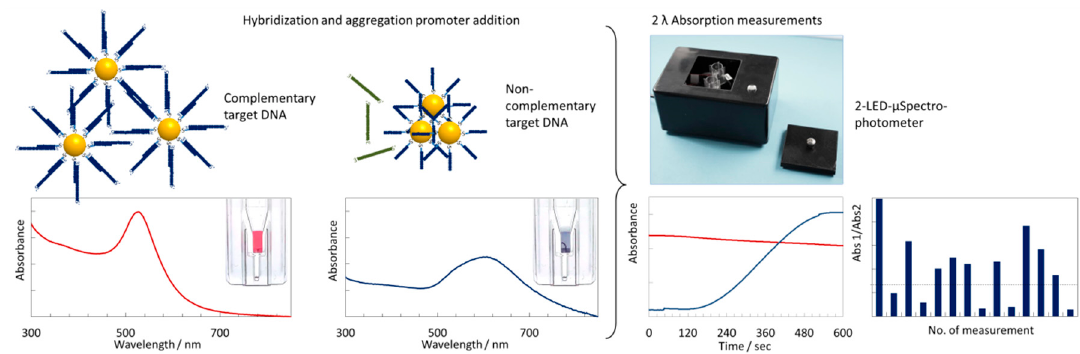
Figure 2. Schematic representation of the DNA sensing strategy. In the presence of DNA and an aggregation promoter (such as salt, acid), oligonucleotide-functionalized AuNPs aggregate, leading to a color change from red to blue, and simultaneously to a shift in the spectrum to higher wavelengths as a result of interparticle plasmonic coupling.